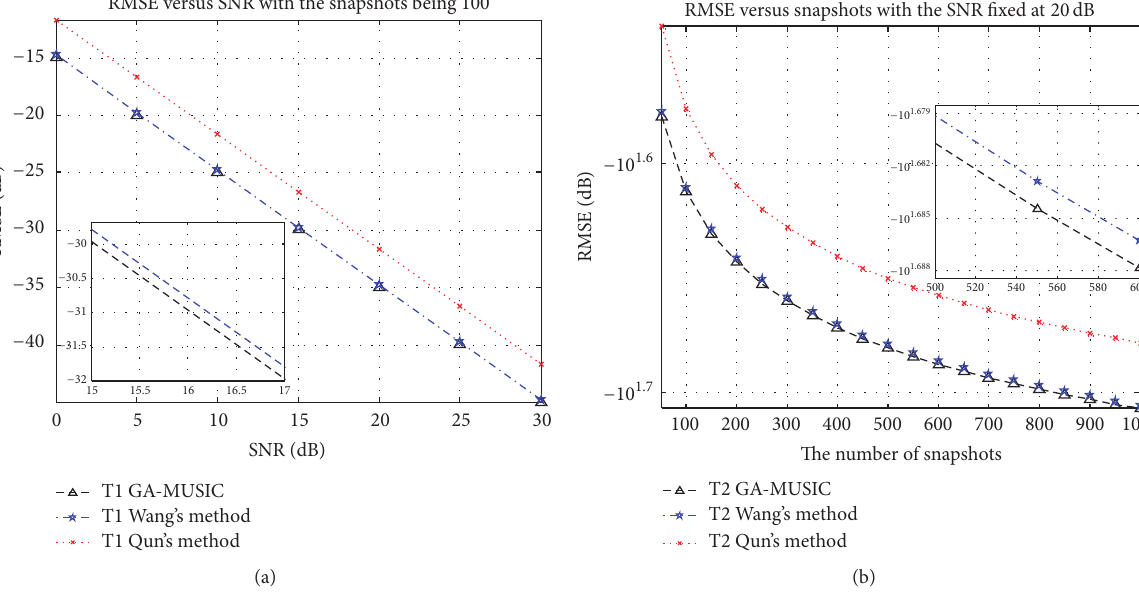
Figure 10: Improvements of GA-MUSIC: (a) RMSE versus SNR with the snapshots being 100 and (b) RMSE versus the snapshots with the SNR fixed at